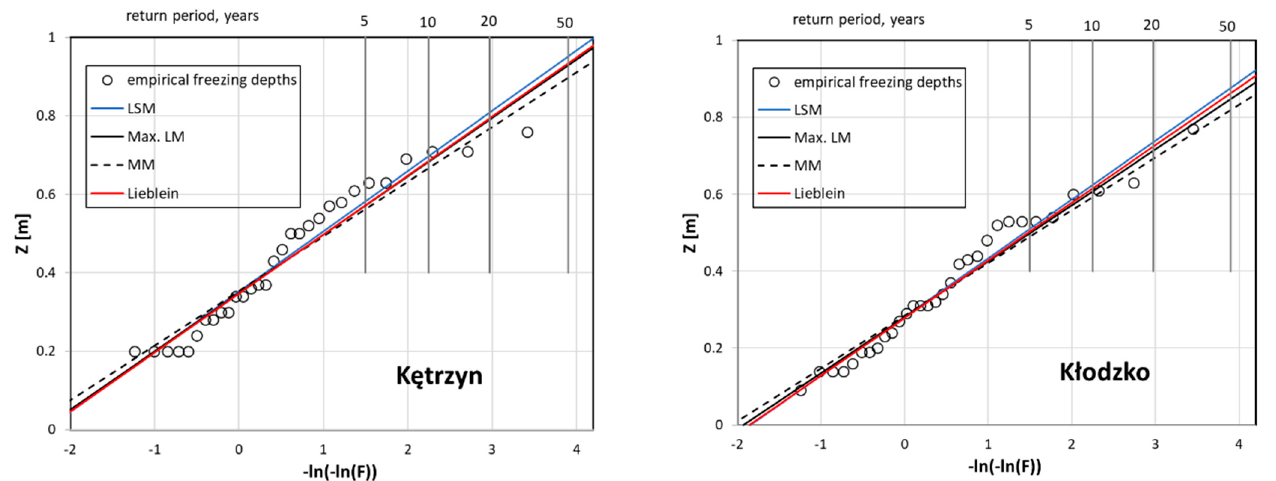
Figure 4. Estimation models for results from Jelenia Góra ( left ) and Kalisz ( right ) station—predicted position of zero iso- therm for return period.